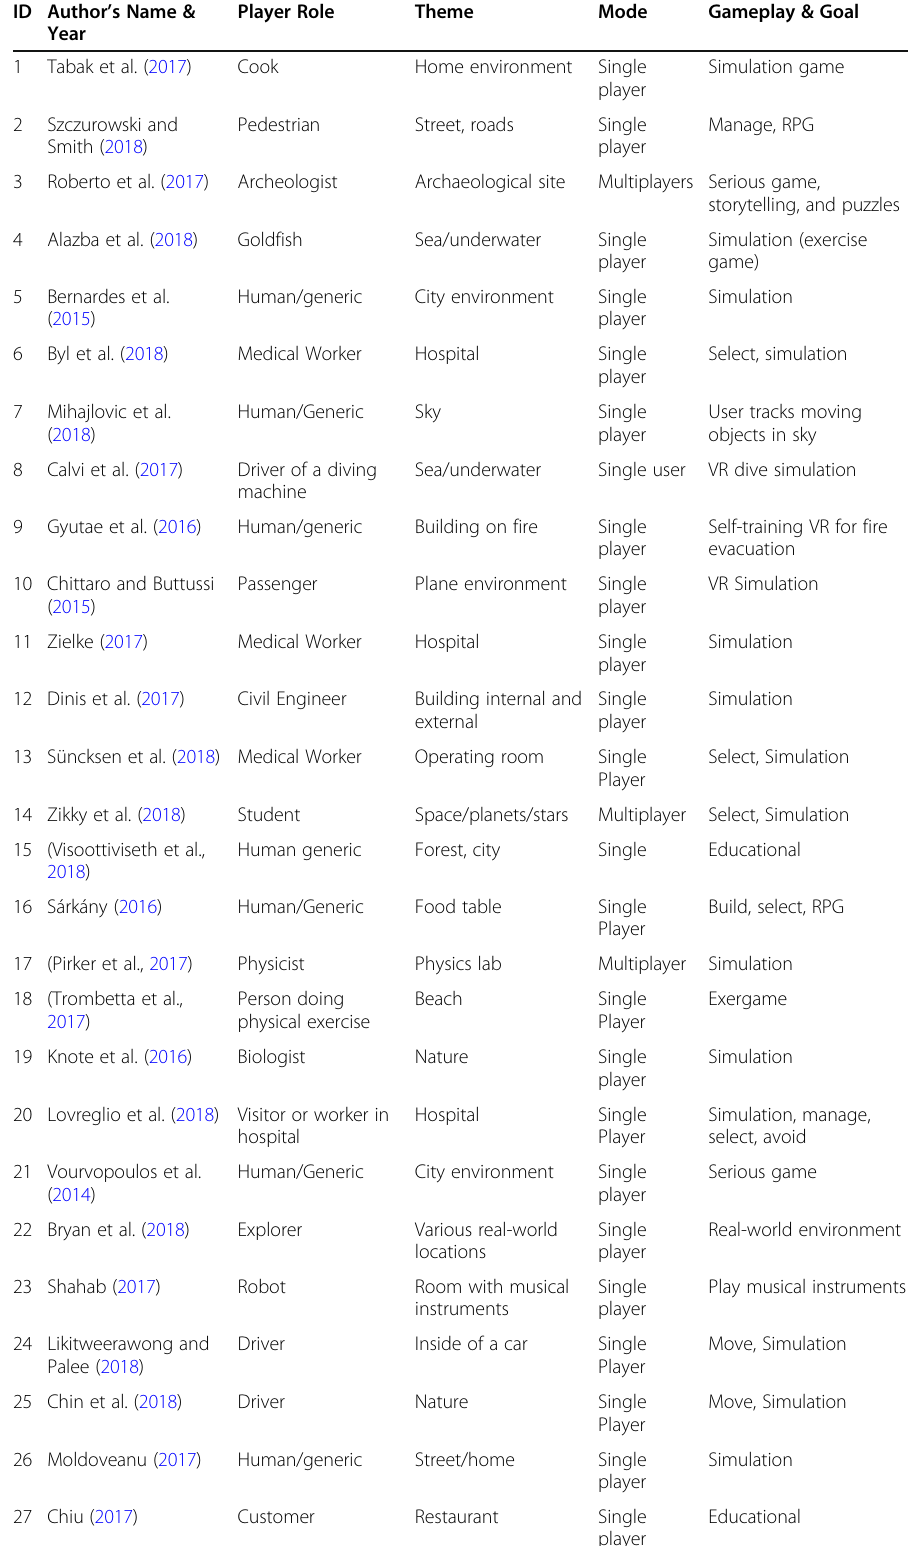
Table 8 Gaming characteristics of